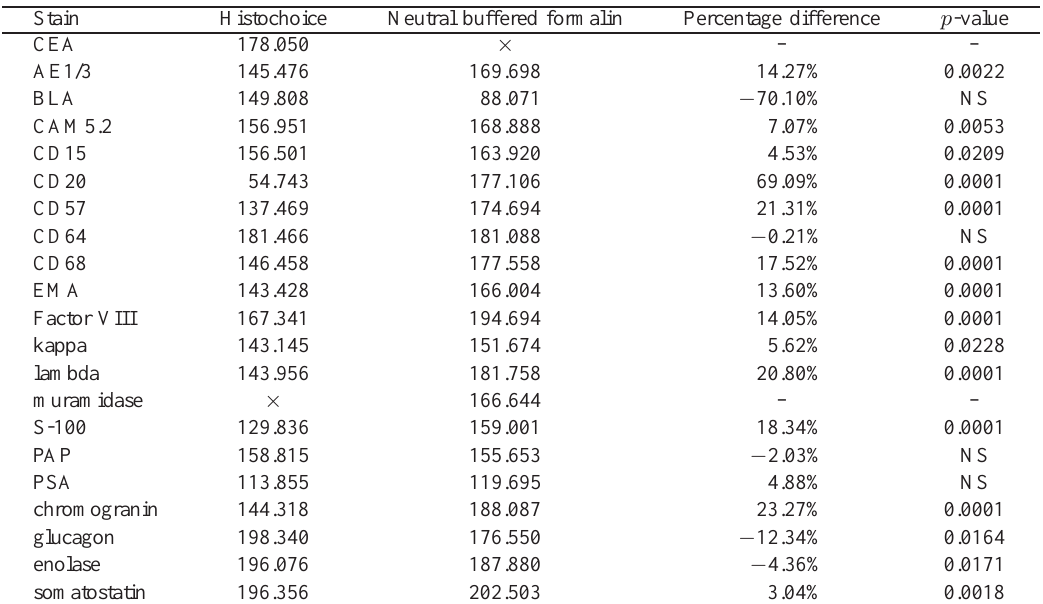
Table 4 Quantitative analysis of value for histochoice and formalin fixed tissue